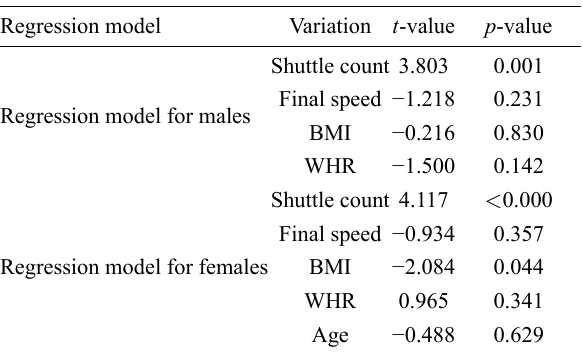
Table 6. Results of t -test for regression coefficients of each independent variable.